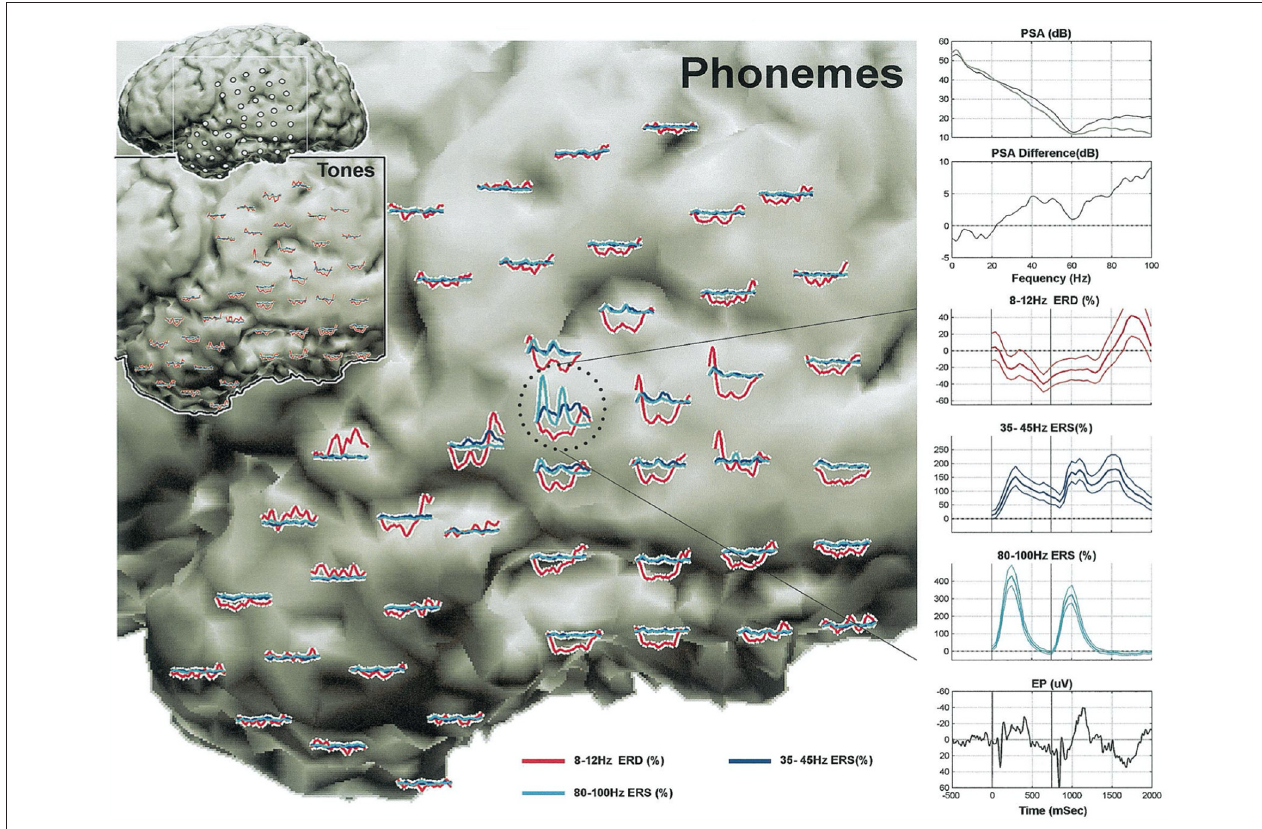
FIGURE 2 | Cortical activity during a receptive language task. From the first study of passive mapping of electrocorticographic activity during a receptive task of distinguishing tones from phonemes by Crone et al. (90). Indices during perception of tones (lower left inset with black border) vs. phonemes (expanded view of left temporal lobe). Plots of event-related power augmentation/suppression are color-coded according to frequency, and correspond to the electrode locations depicted in the upper left corner inset (white frame indicates borders of the expanded views). Detailed plots in the right column are derived from an electrode over the left superior temporal gyrus (circled). PSA, power spectral array; ESD, event related desynchronization; ERS, event related synchronization; EP, evoked potential. From Crone et al.